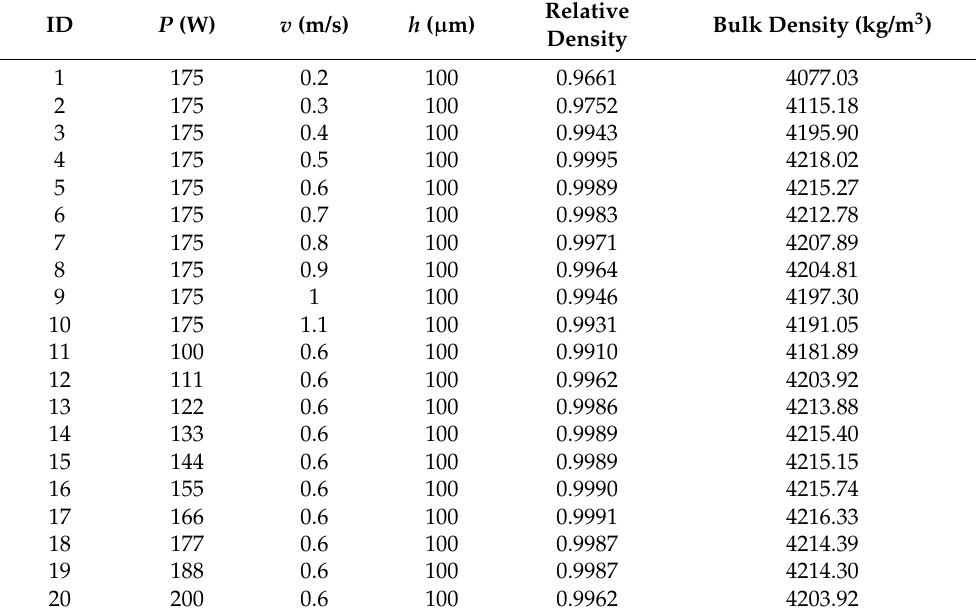
Table A11. Manufacturing parameters and experimental data adapted from [25]. Complementing relevant information and assumptions are the following; material: Ti6Al4V, theoretical density